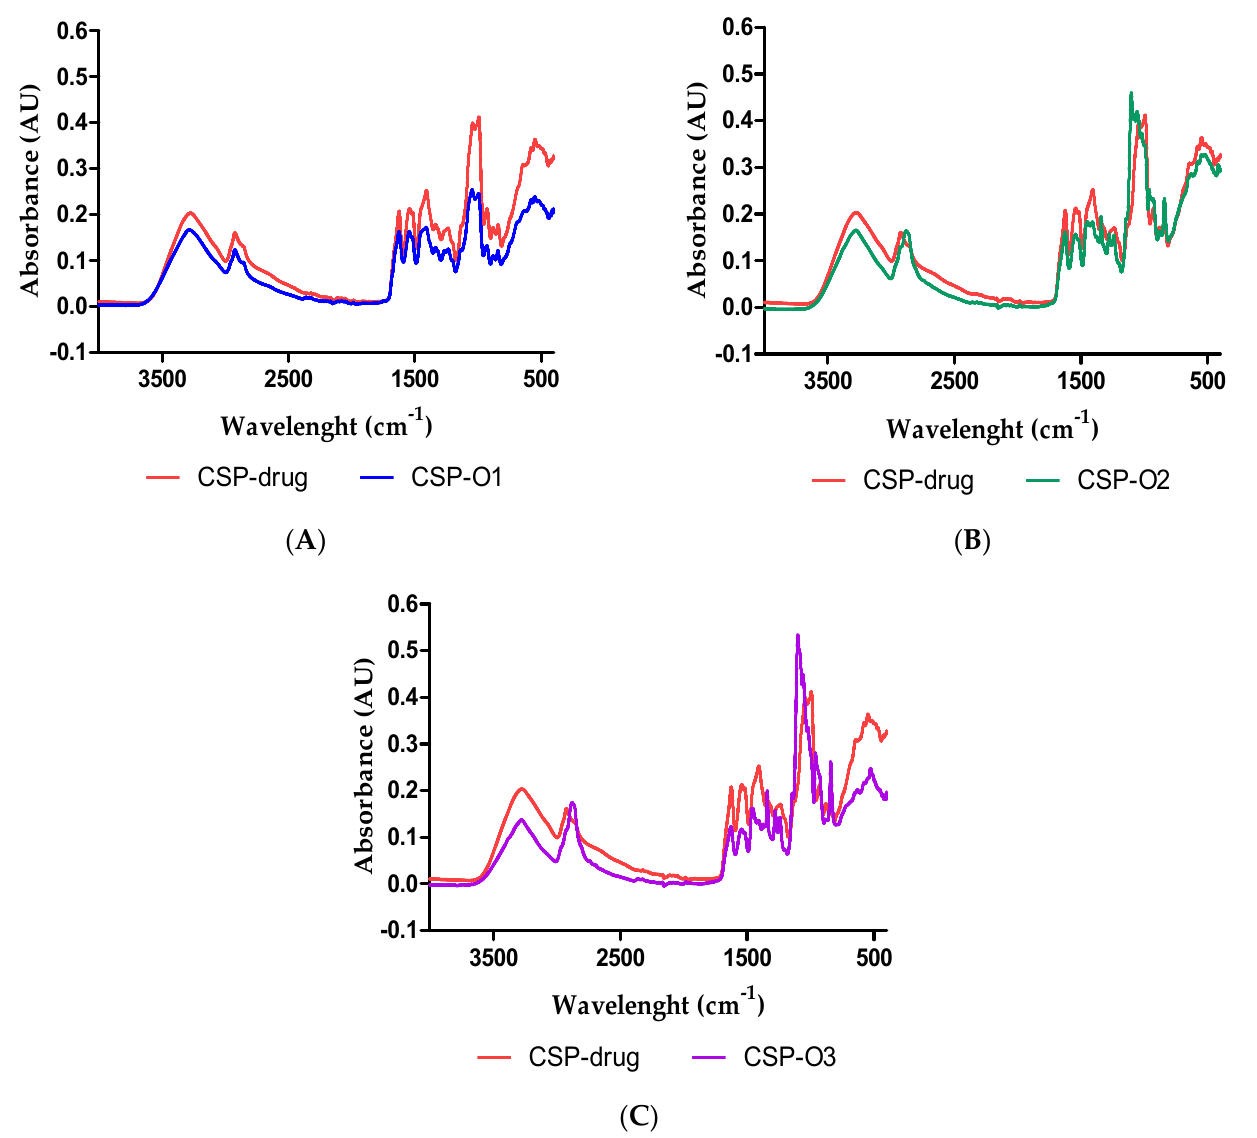
Figure 3. FTIR spectra of: ( A ) CSP drug vs. CSP-O1; ( B ) CSP drug vs. CSP-O2; and ( C ) CSP drug vs.